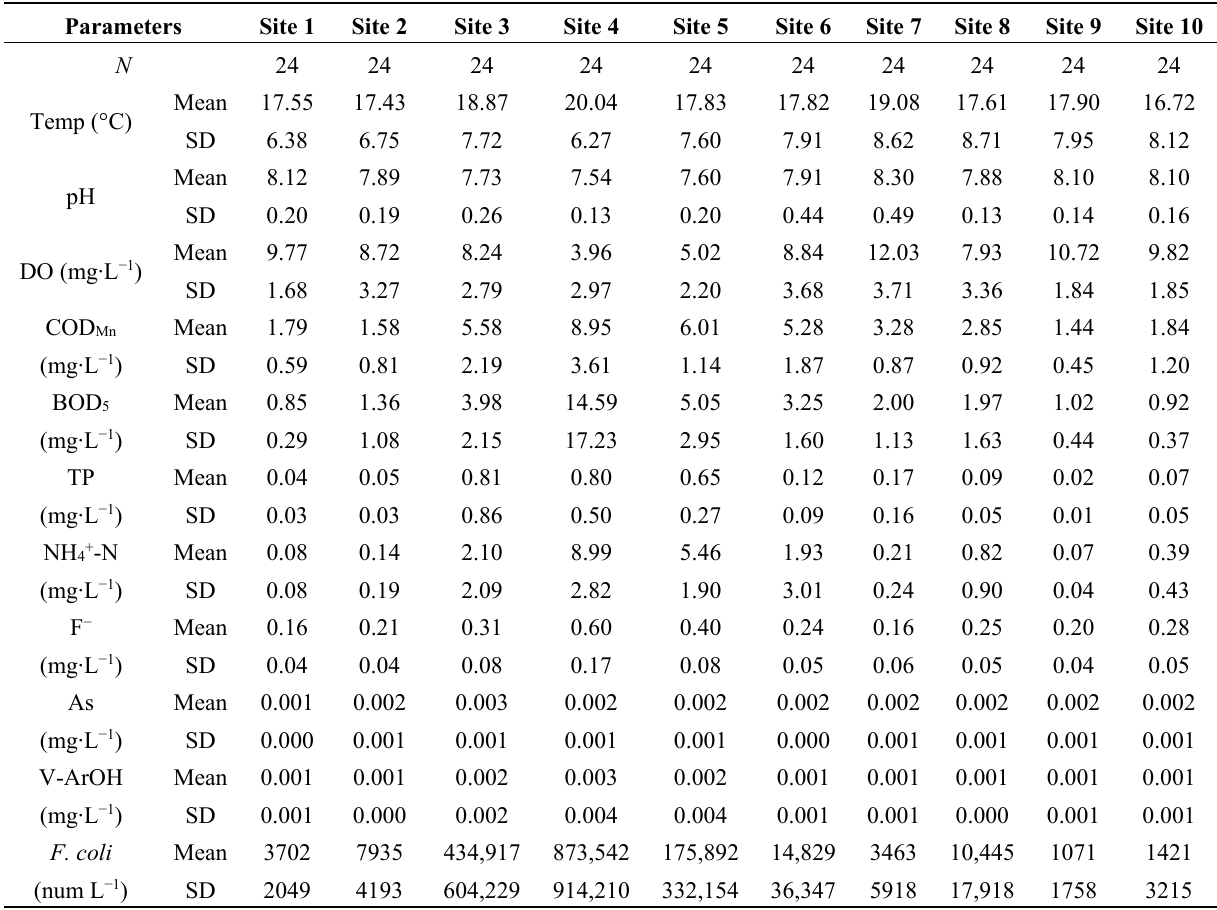
Table 2. Univariate statistics of the water quality